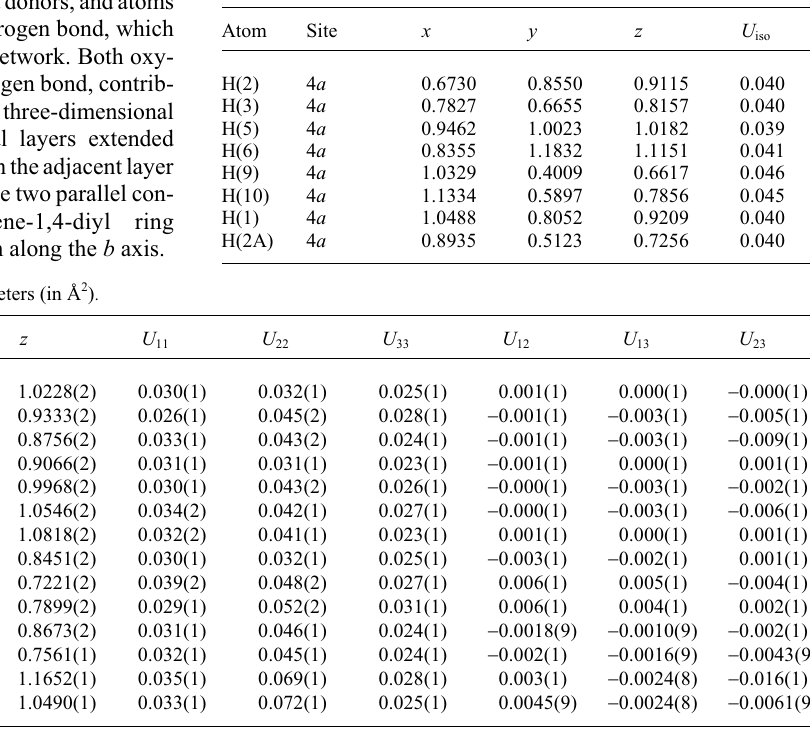
Table 2. Atomic coordinates and displacement parameters (in Å 2 ) .